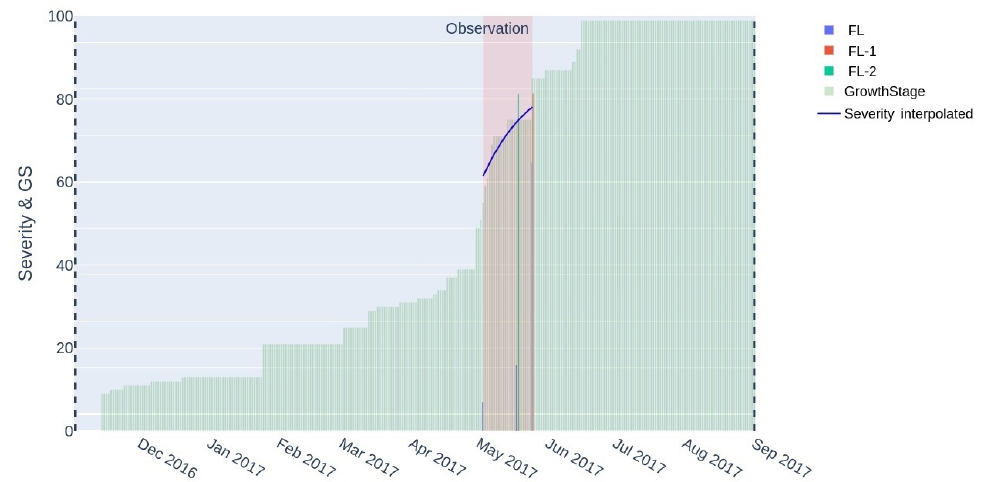
Figure 3. An example trial representing the complete lifecycle of the cropping season, with growth stage (GS) represented in BBCH standard and disease severity information. The red zone in this example between May 2017 represents a window where the yellow rust severity observations are collected from field trials.